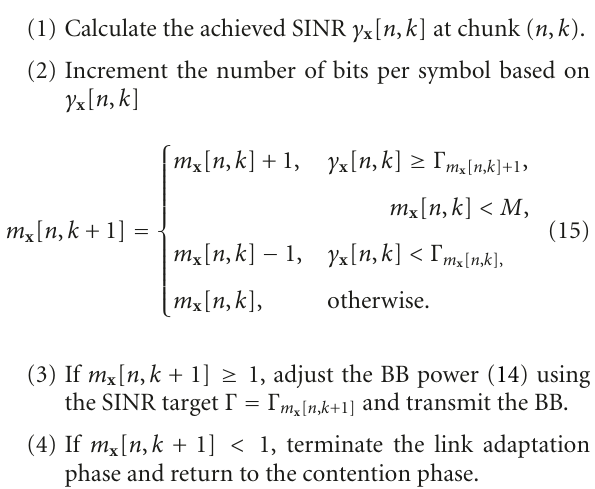
Figure 4: Manhattan grid urban microcell